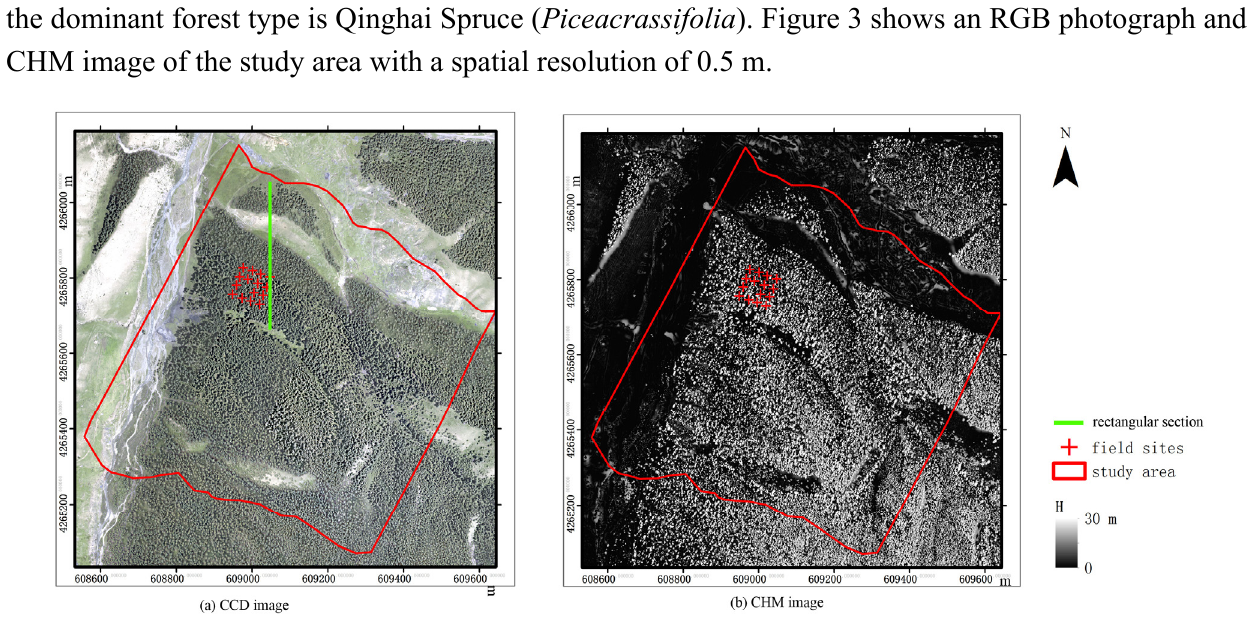
Figure 3. Distribution of the study area and field sites on ( a ) RGB photograph and ( b ) CHM image. Both images have a spatial resolution of 0.5